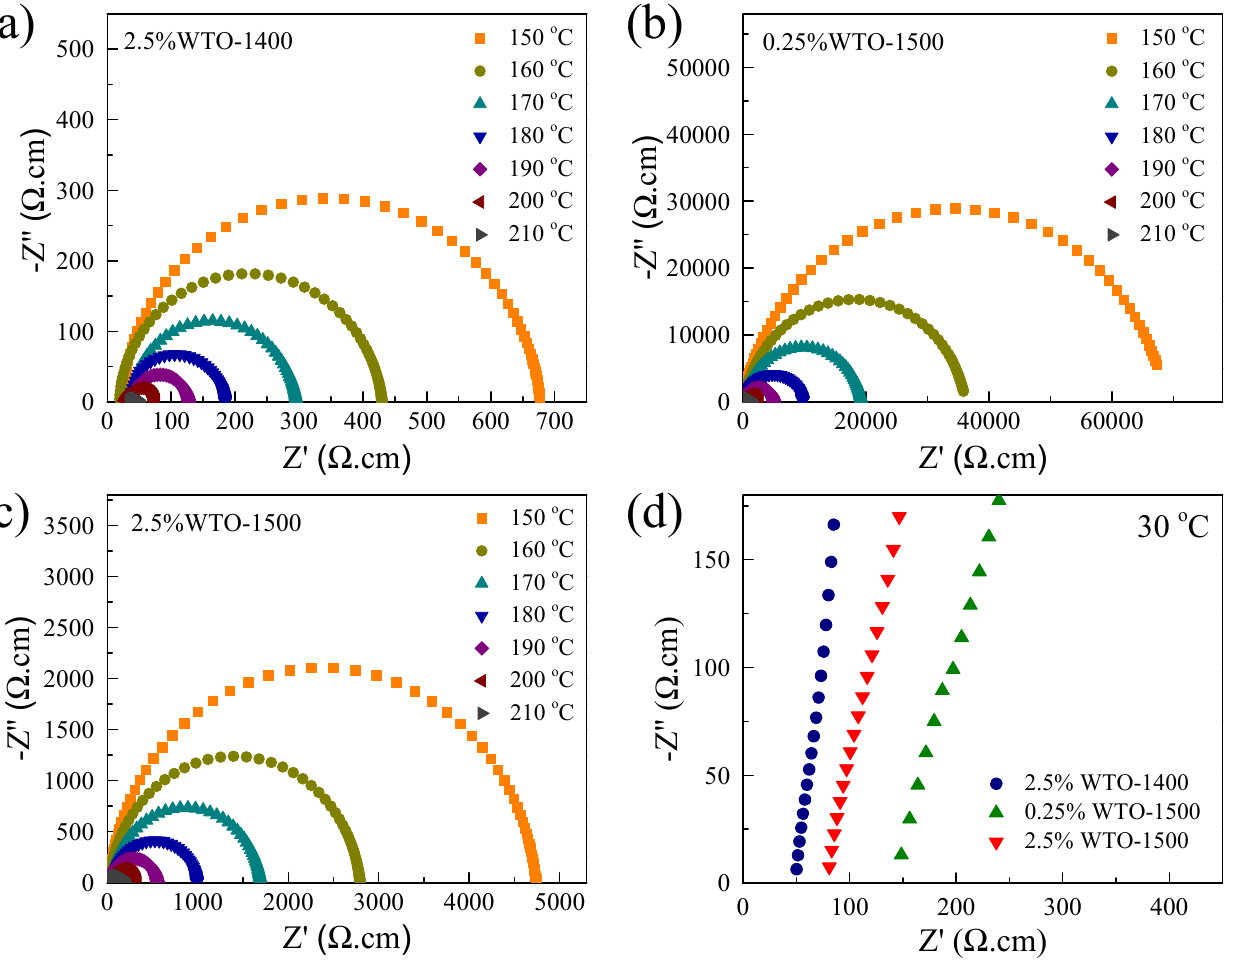
Figure 7. Impedance complex Z* plots with various temperatures of ( a ) 2.5%WTO-1400, ( b ) 0.25%WTO-1500, and ( c ) 2.5%WTO-1500 ceramics. ( d ) Nonzero intercept at the origin of WTO ceramics.